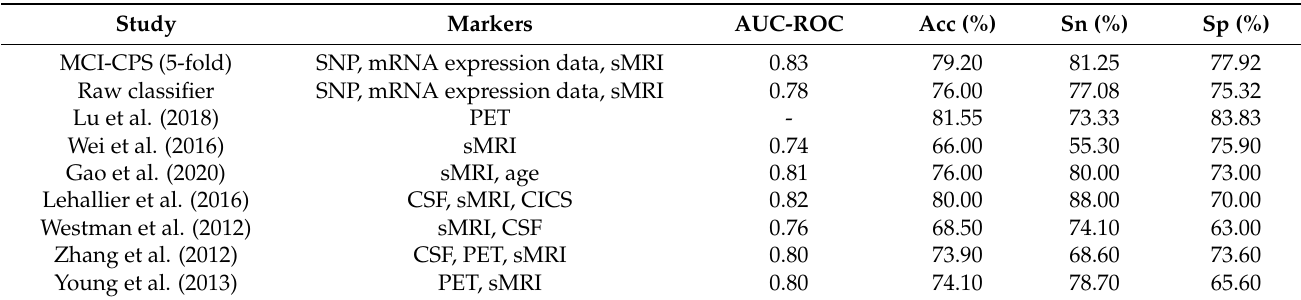
Table 4. Comparison of methods for predicting conversion from MCI to AD between this study and similar recent studies. First row: MCI-CPS (5-fold), classification after applying SNF method from ADNI-1 dataset. Second row: Raw classifier, model without SNF in ADNI-1. Other rows list performance of compared